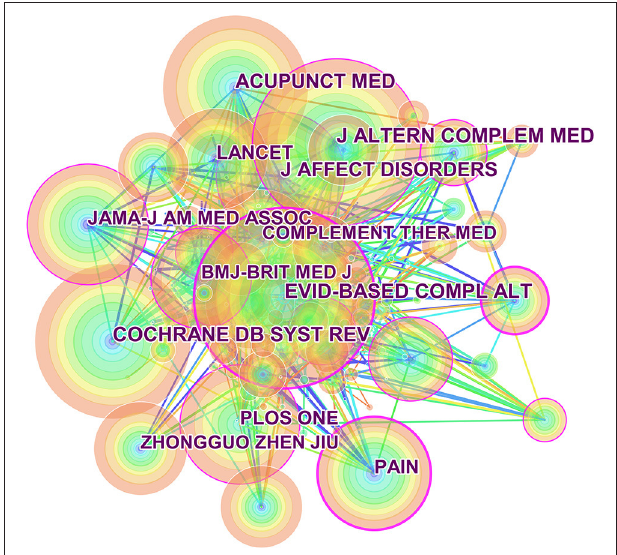
FIGURE 1 | The annual number of publications on acupuncture for depression from 2011 to 2020.